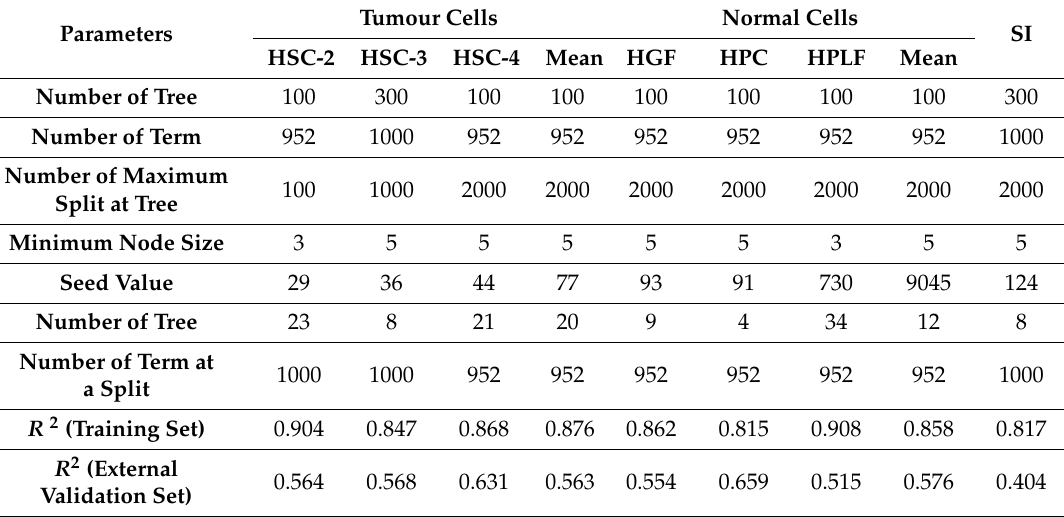
Table 3. Parameters of each model by random